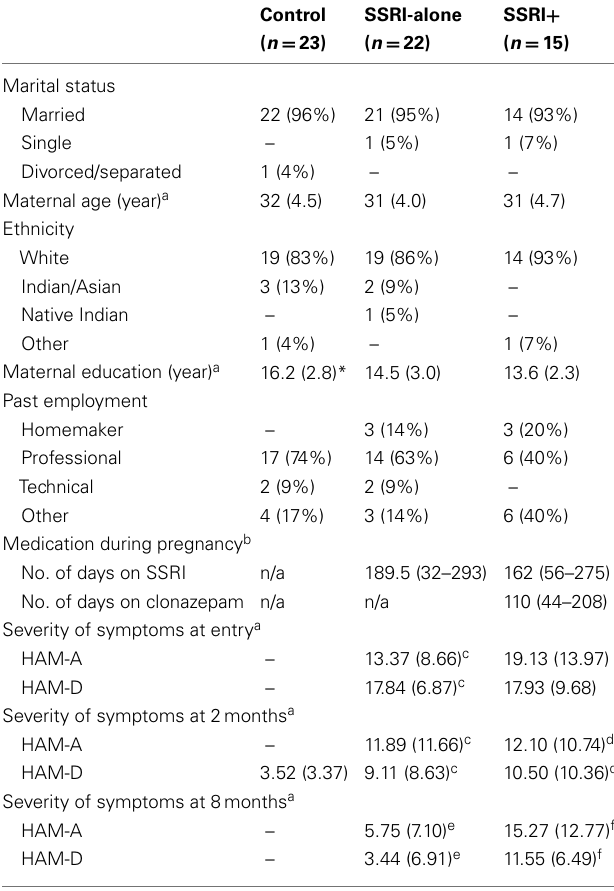
Table 3 | Maternal background demographic characteristics.